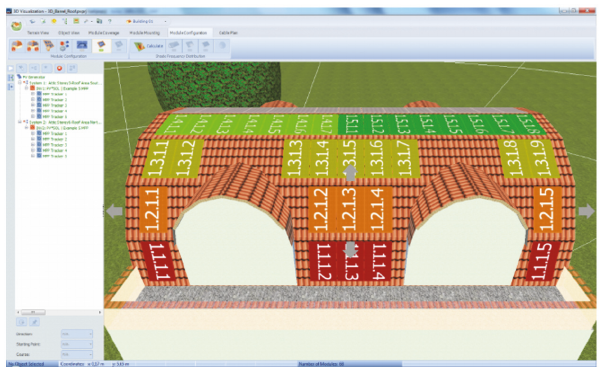
Figure7:PV ∗ SOL 3D visualization of PV energy evaluation (source: http://www.valentin-software.com/en/products/photovoltaics/57/pvsol-